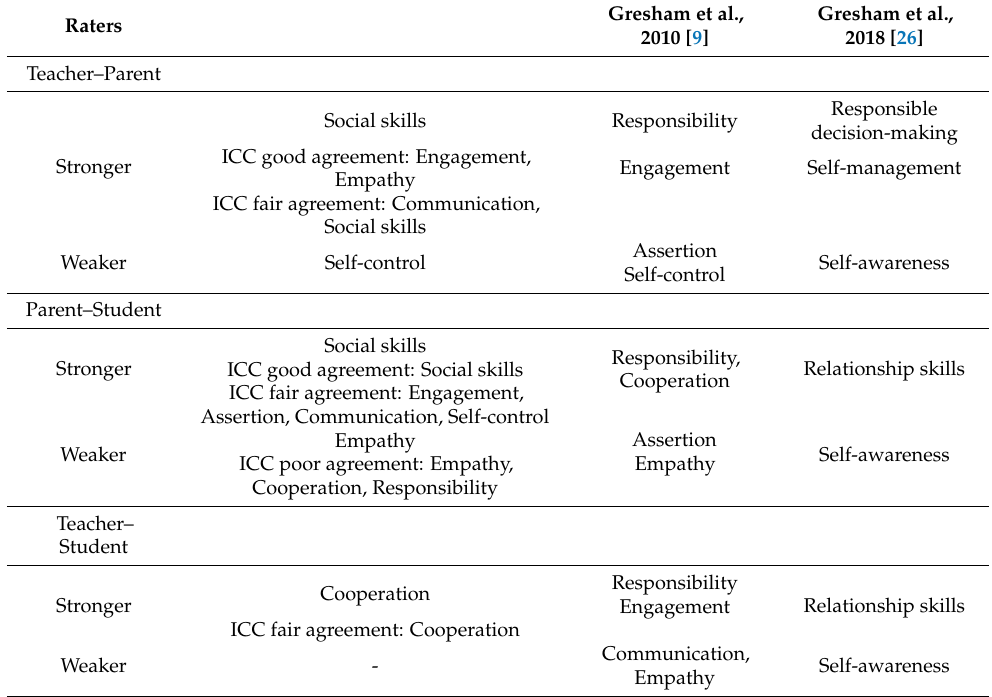
Table 8. Comparison of social skills with stronger and weaker agreement across raters and